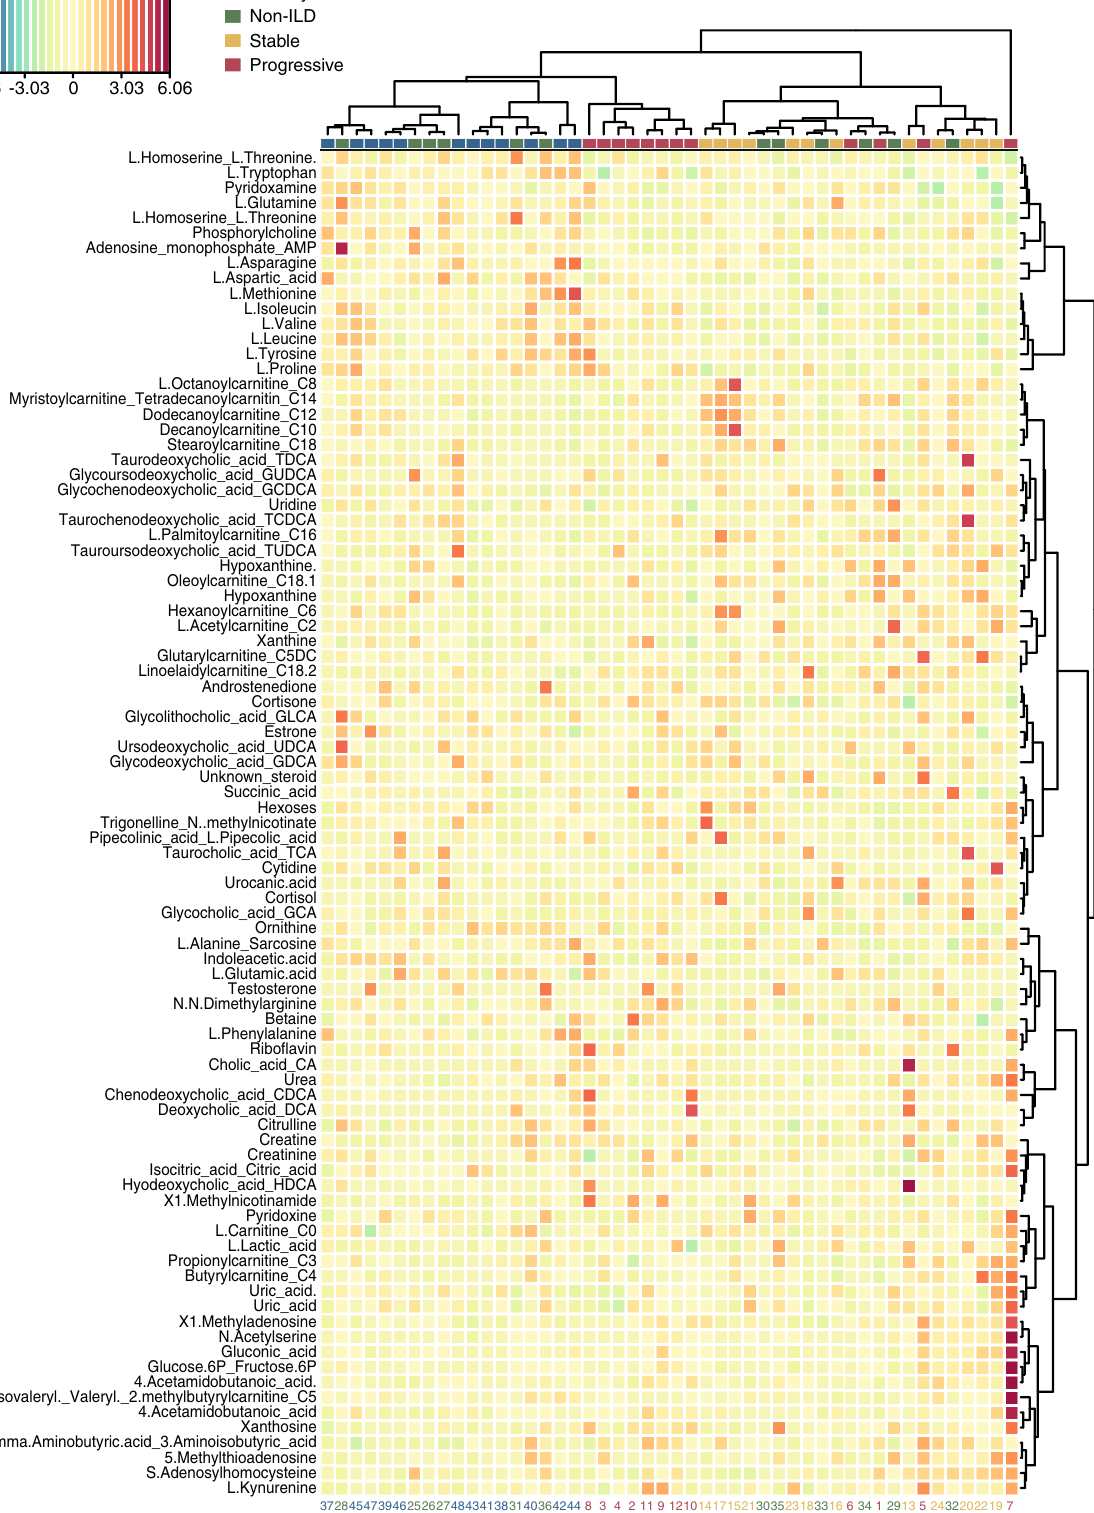
Figure 2. Hierarchical clustering of metabolomics data using Euclidean distance and direct